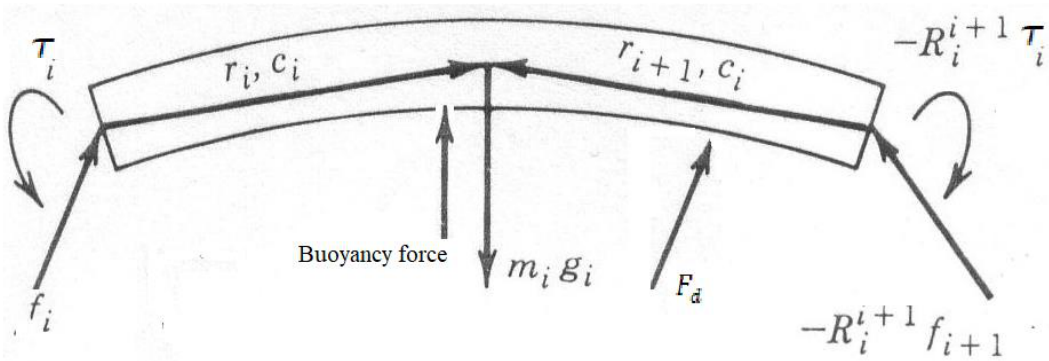
Figure 16. Free body diagram of forces and moments on link i.